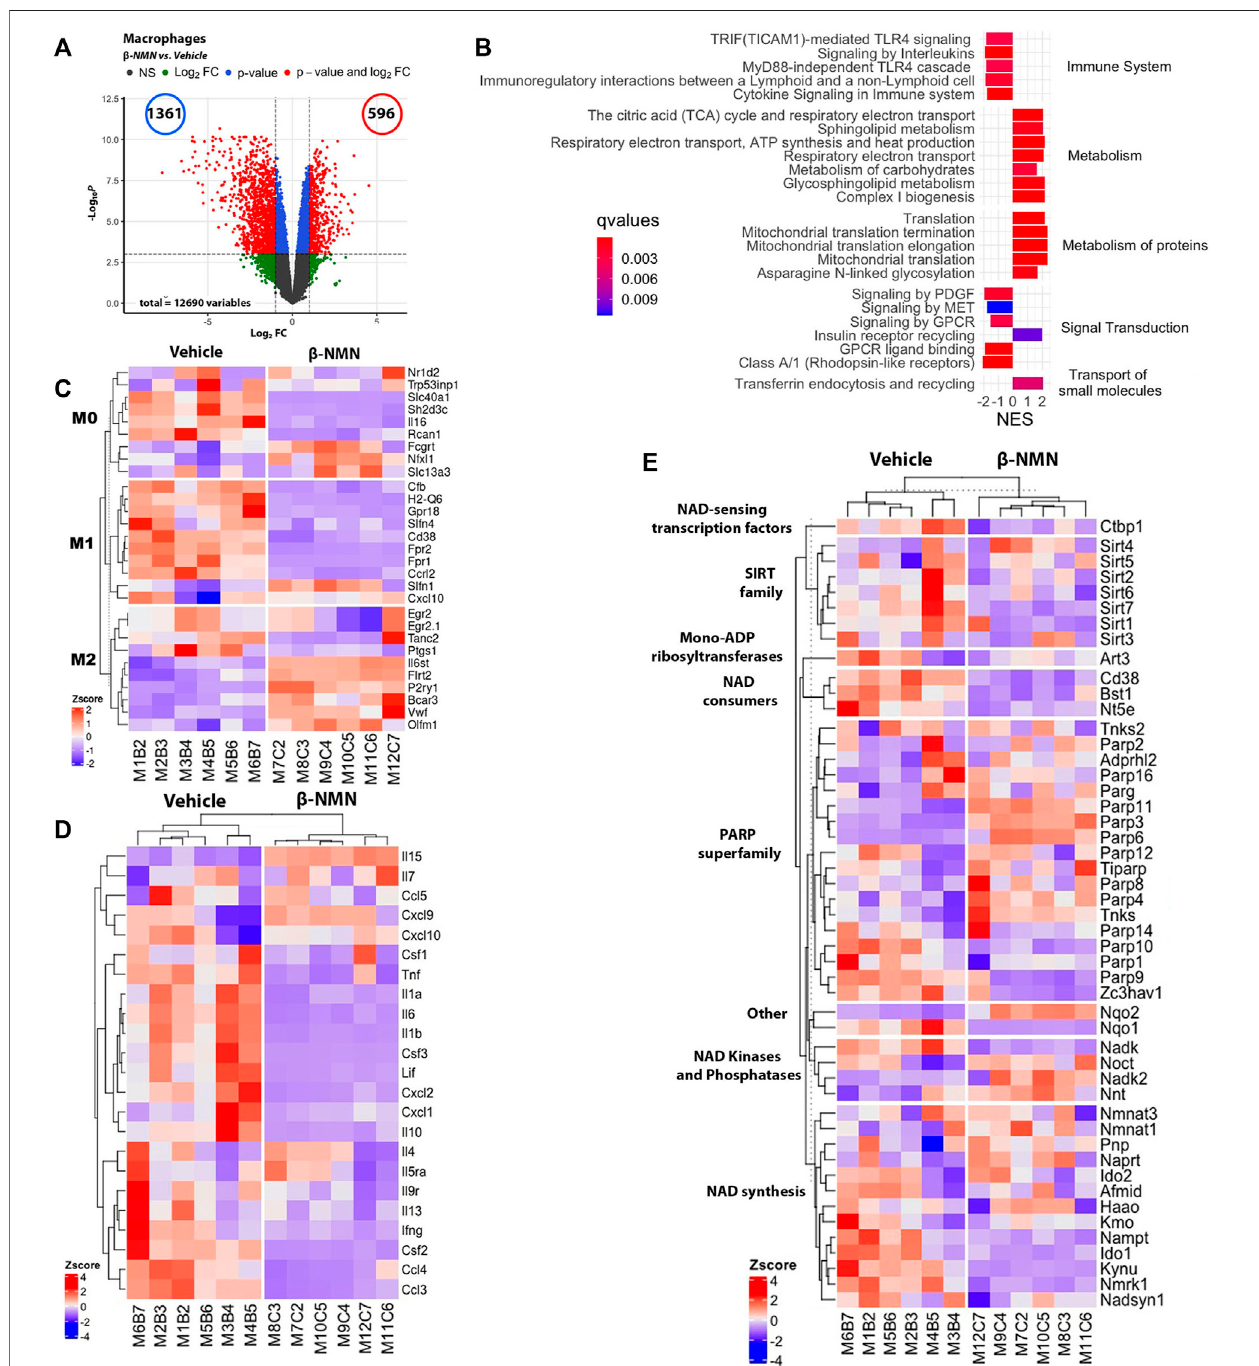
FIGURE5| Identi fi cationofdifferentiallyexpressedgenesinperitonealmacrophagesfollowingstimulationwith E.coli intheTGC-inducedperitonitismousemodel. Peritonealmacrophageswereculturedinthepresenceof E.coli for6 handthensubmittedtotranscriptomicanalysisusing denovo RNAsequencing. (A) Volcanoplotof geneexpressionofperitonealmacrophages[plotofgeneexpressionlog2-transformedfold-changes( x -axis)vs.-log10 p -value( y -axis)].Thereddotsrepresentthegene havingfold-changes > 2.0,andadjusted p -values < 0.05between β -NMNandvehiclegroups. (B) EnrichmentplotofdifferentiallyexpressedReactomepathways( β - NMN vs. vehicle) in peritoneal macrophages. Normalized enrichment score (NES) re fl ects the up- (NES > 0) and down- (NES < 0)expressed pathways, and gradient color re fl ects the adjusted p -values < 0.01. (C – E) Hierarchical clustering heatmap of M0, M1, and M2 phenotype- (C) , cytokine production- (D) , and NAD + metabolism- (E) associated genes expressed by peritoneal macrophages. Red colors indicate Z-score > 0 (up-regulation); blue colors indicate Z-score < 0 (down-regulation); white color indicates Z-score = 0 (no difference). For all data n = 6 for each